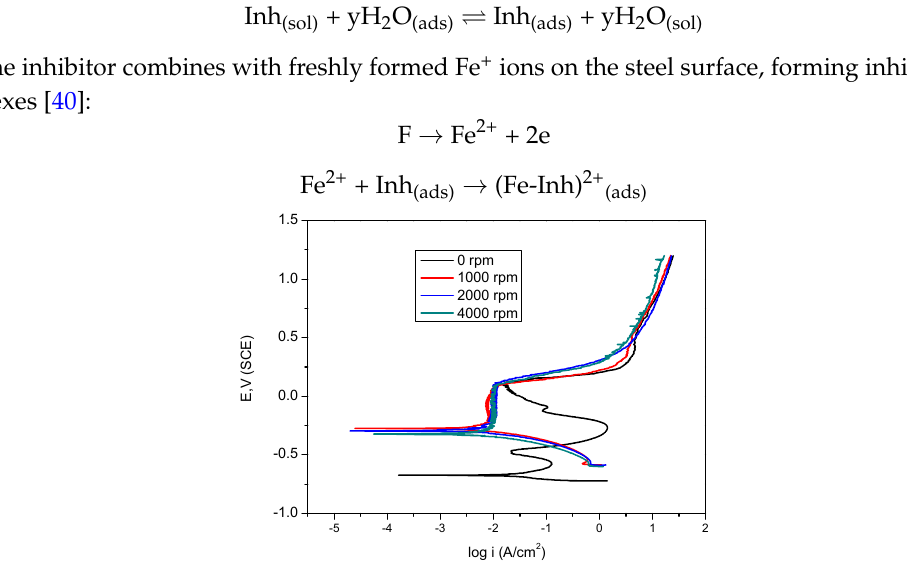
Figure 6. Polarization curves for mild steel in bicarbonate/chloride solution under stagnant conditions and different rotation speeds in the presence of 2 g/L NO 2 − + 2 g/L KI at room temperature.